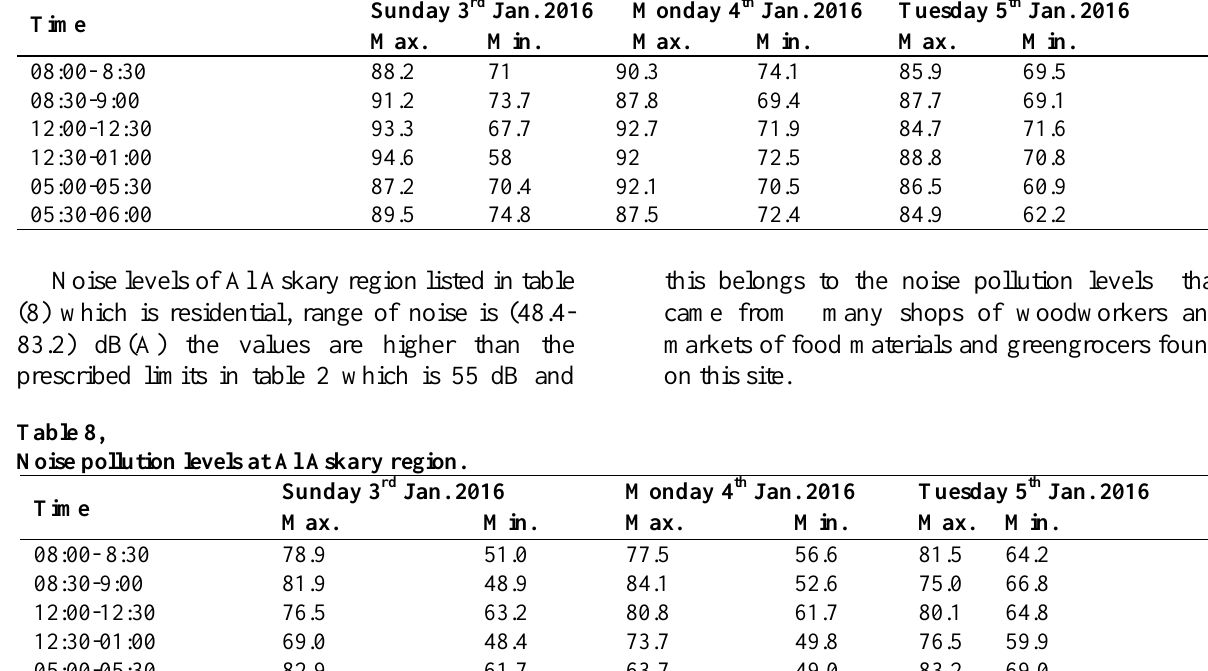
Table 6, Noise levels of different sources of traffic (Khitolya, 2007) Source of Noise Table 7 represents the values of noise in the third region at ALWasti .The location of the site is Table 7, Noise levels at Al Wasti region.